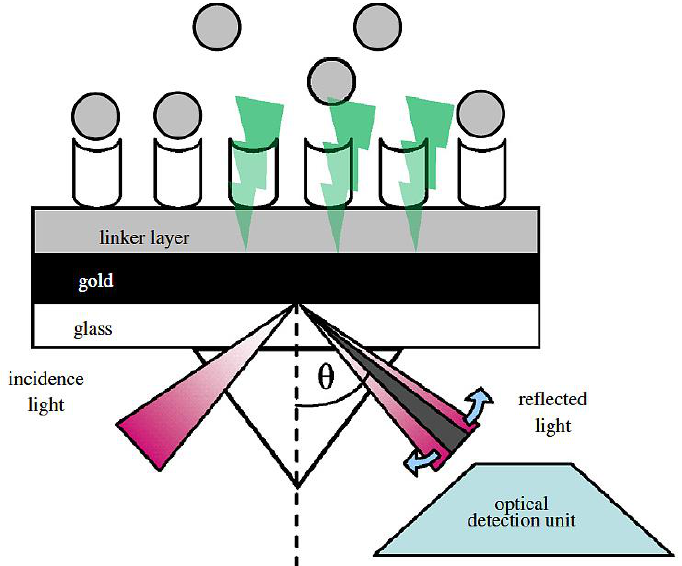
Figure 11. Schematic of working principle of surface plasmon resonance (SPR) biosensor